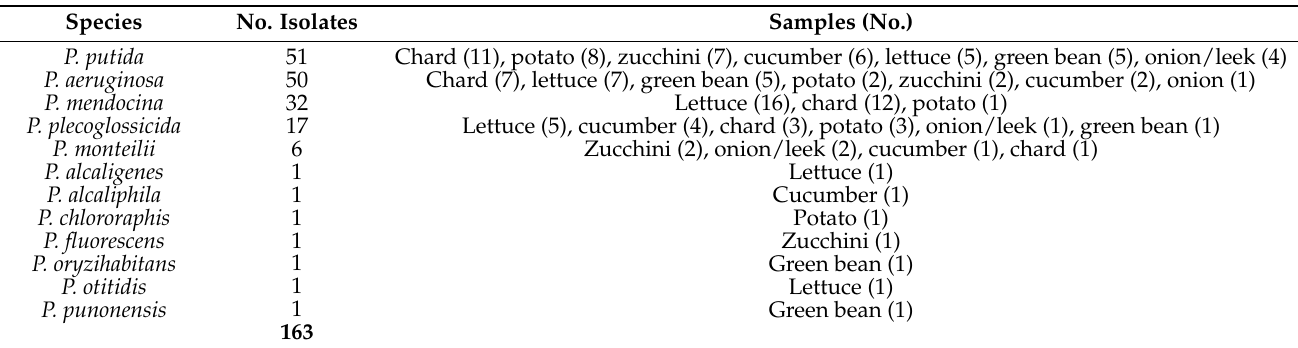
Table 1. Description of the twelve different Pseudomonas species isolated from raw vegetables, including the number of isolates and the samples where they were recovered. Species No. Isolates Samples (No.) P.